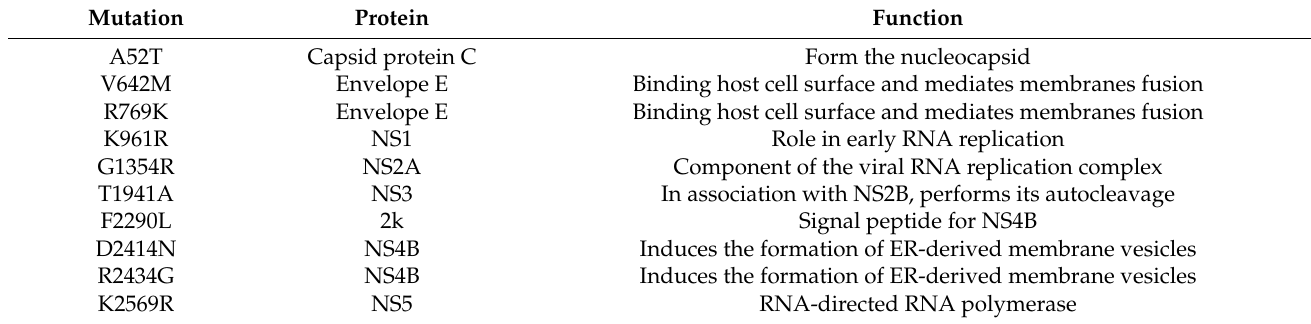
Table 3. Amino acid mutations fixed in the lineage leading to the 2020 Spanish outbreak studied. Mutation